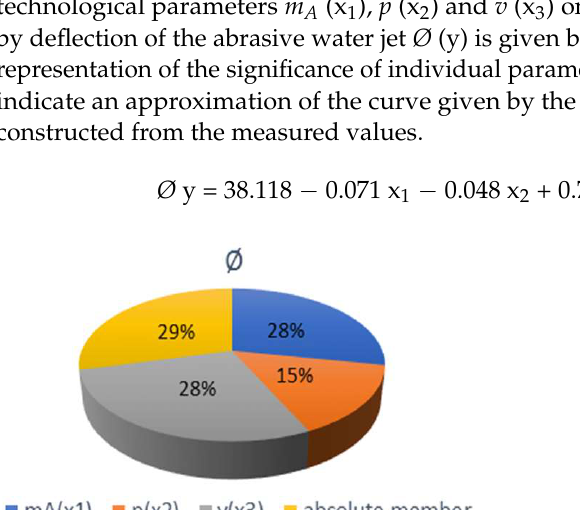
representation of the significance of individual parameters. These indices of determination